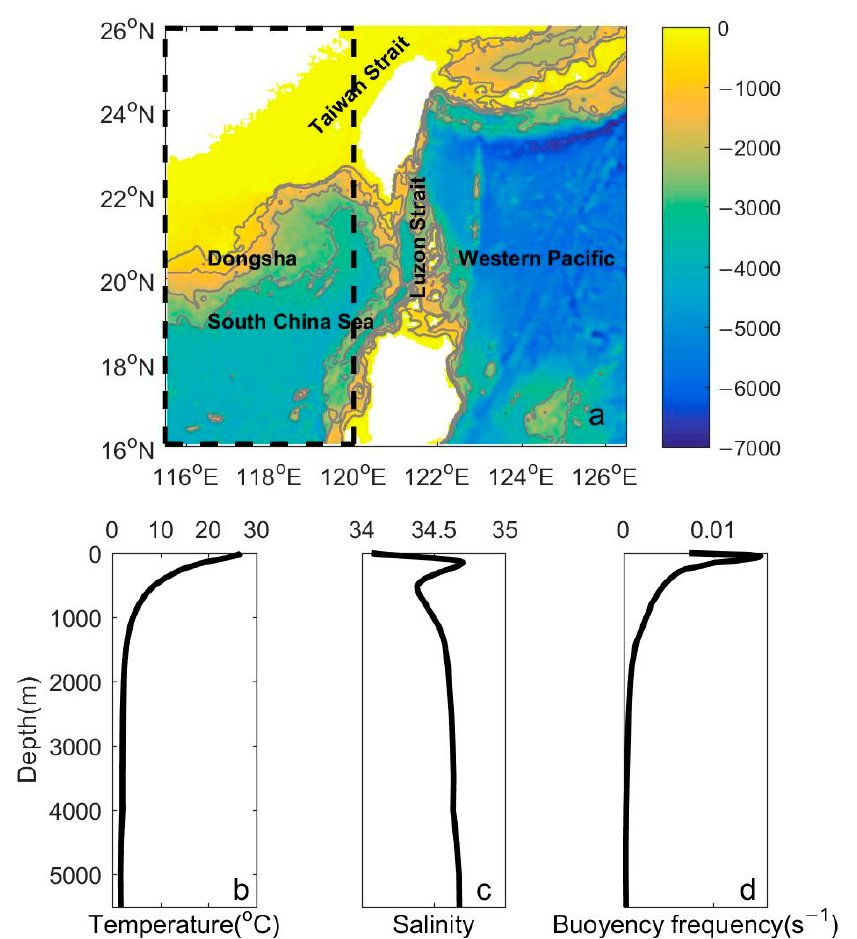
Figure 1. ( a ) Depth in the northern SCS (shading, unit: m). Gray lines indicate isobathic contours of − 3000, − 2000, − 1000, and − 500 m. The dashed rectangle denotes the simulation area for the Slope case. Initial ( b ) temperature, ( c ) salinity, and ( d ) buoyancy frequency profiles in the model.